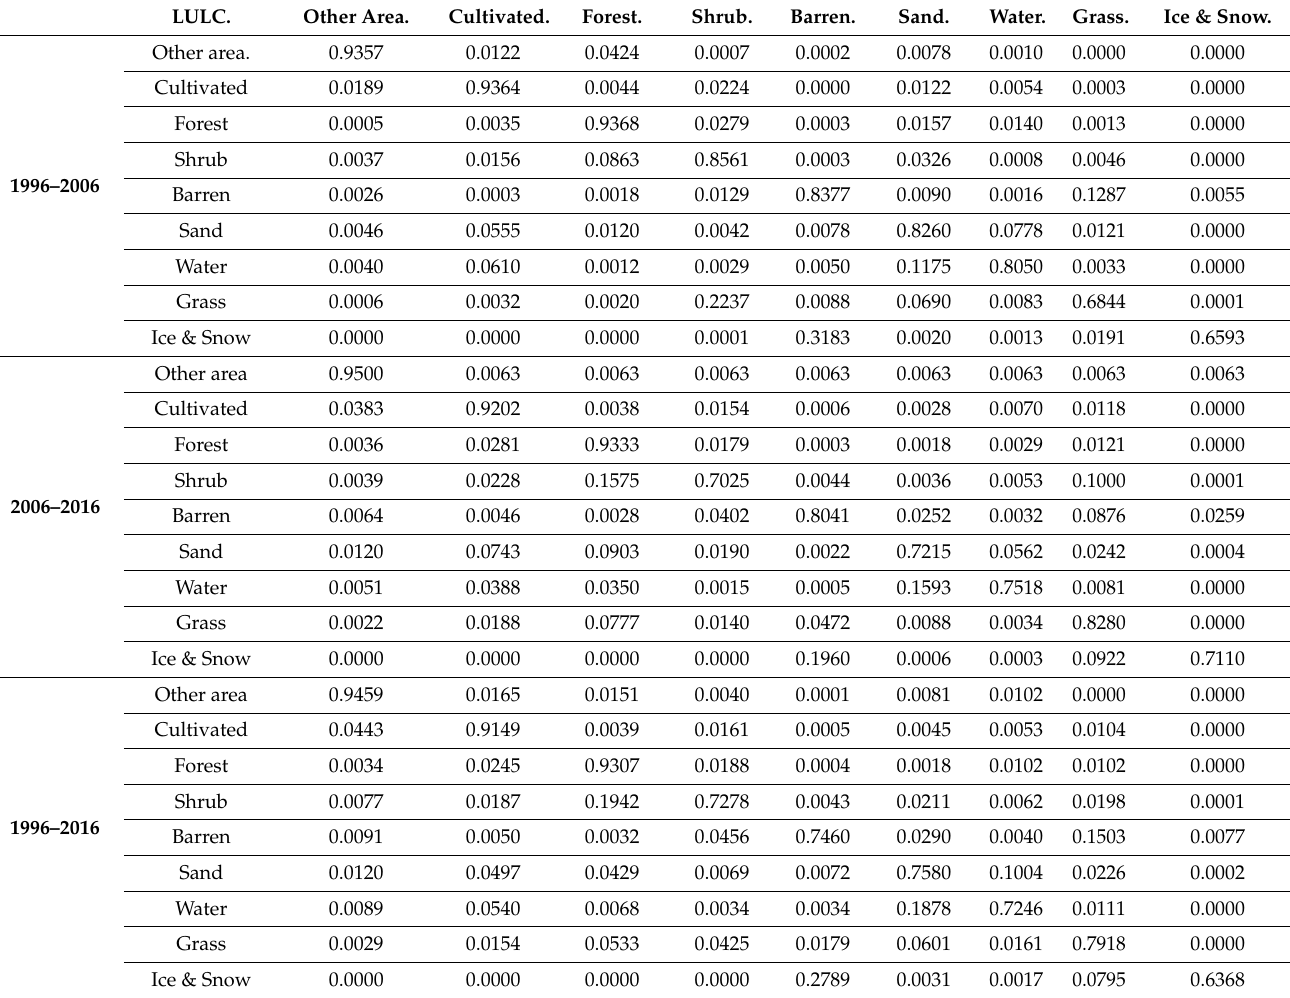
Table A1. Transition probability matrix calculated using land-cover maps of 1996–2006, 2006–2016, and 1996–2016.